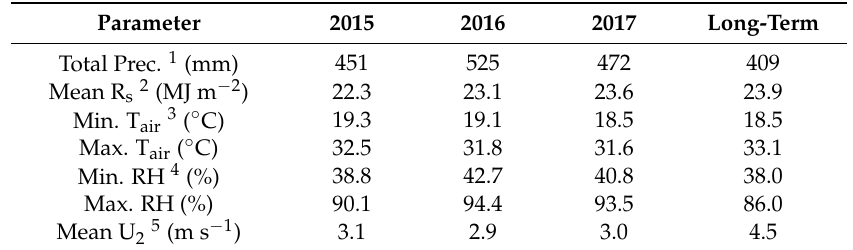
Table 1. Meteorological parameters for May–September during each of the three study years and the long-term (1981–2010) period.